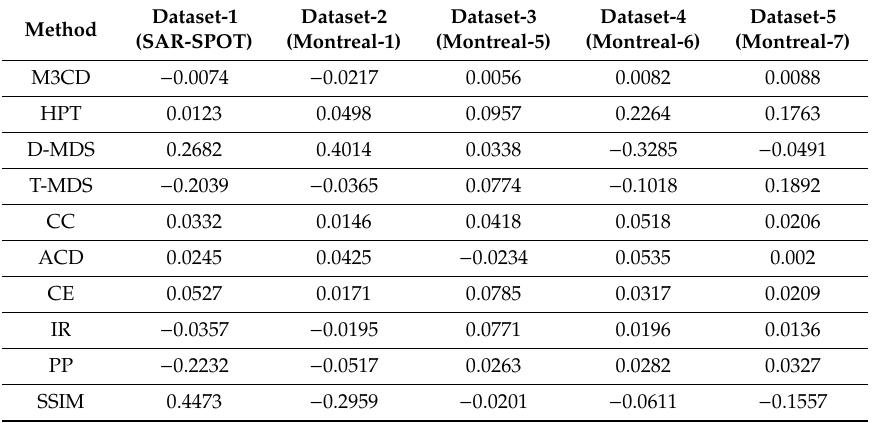
Table 7. AUC Di ff erences between using single band case and using EMAP-synthetic bands for change detection.